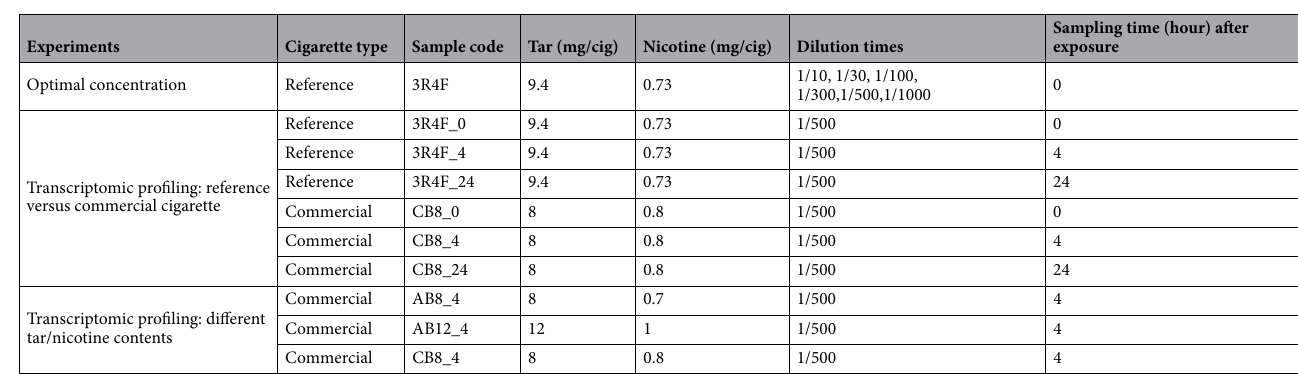
Table 1. Summary of smoke exposure experiments for validation in this